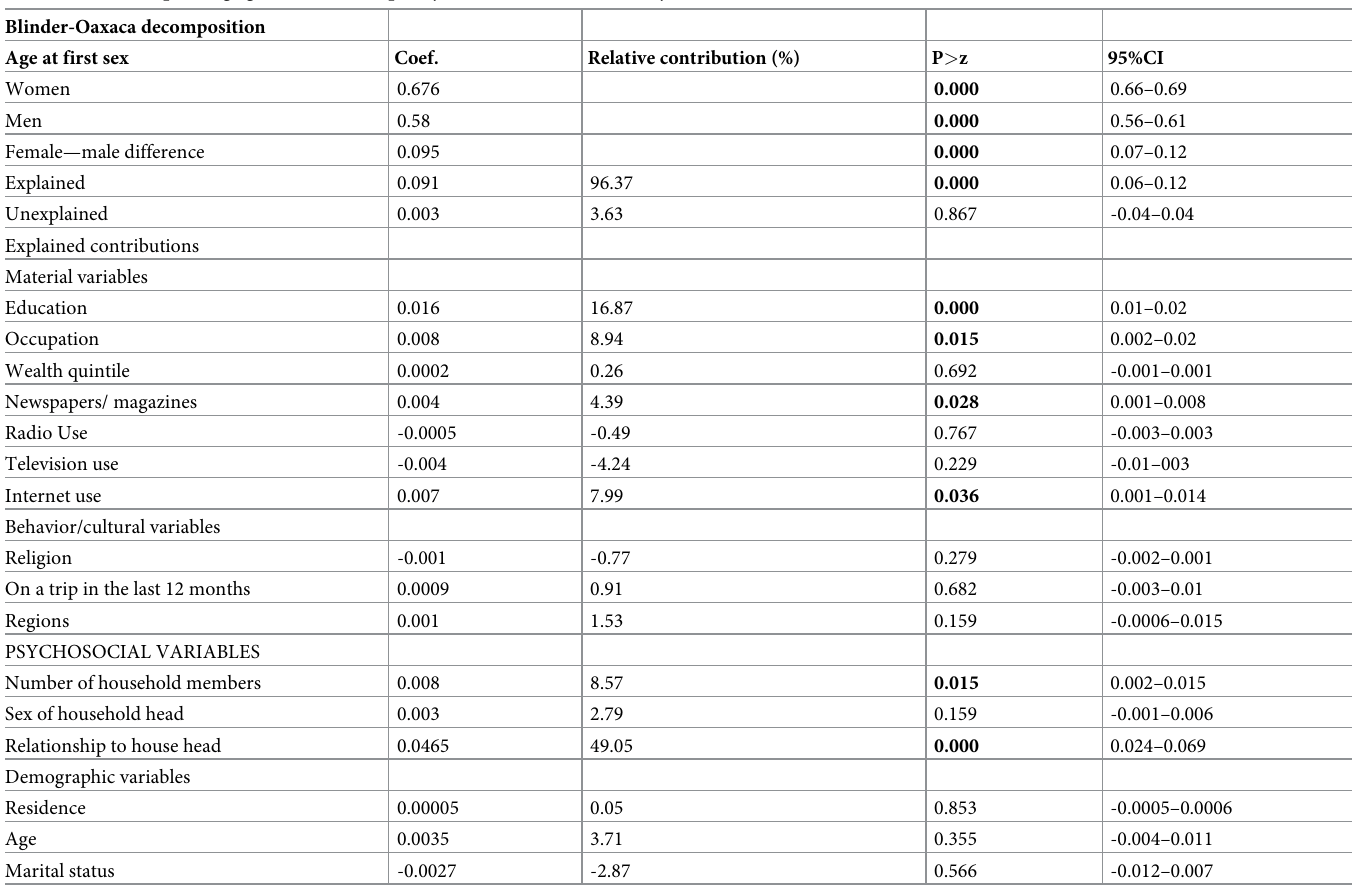
Table 5. Factors explaining age at first sex inequality between men and women youth.